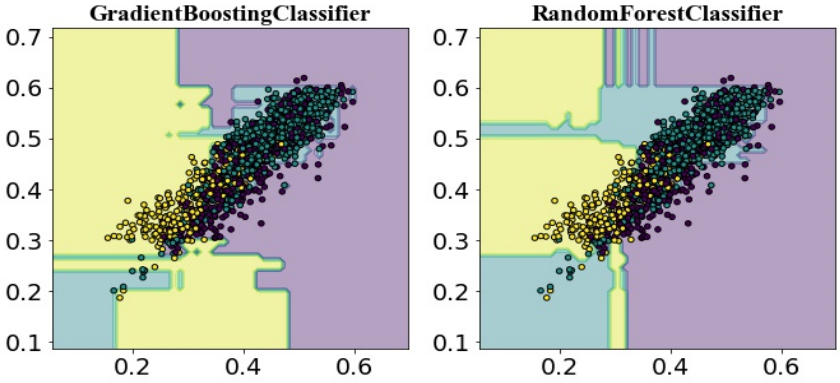
Figure 11. The decision boundaries of GB and RF classifiers.